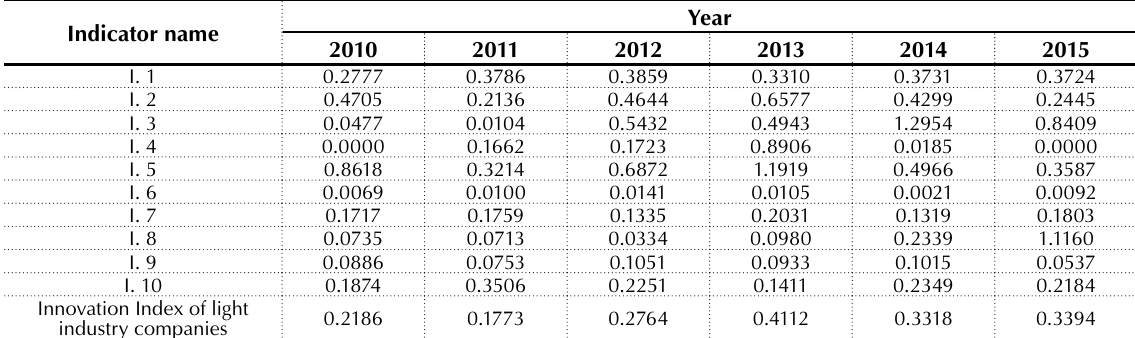
Table 3. The normalized values of indicators of innovation activity and the Innovation Indexes of light industry companies in Ukraine